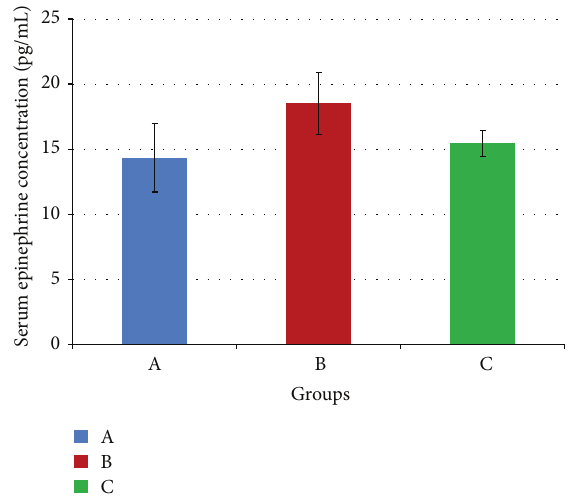
Figure 1: Mean serum epinephrine concentrations of rats in groups A, B, and C at the end of the four-week treatment period. Group A: control (HSD/HFD); group B: stress + HSD/HFD; group